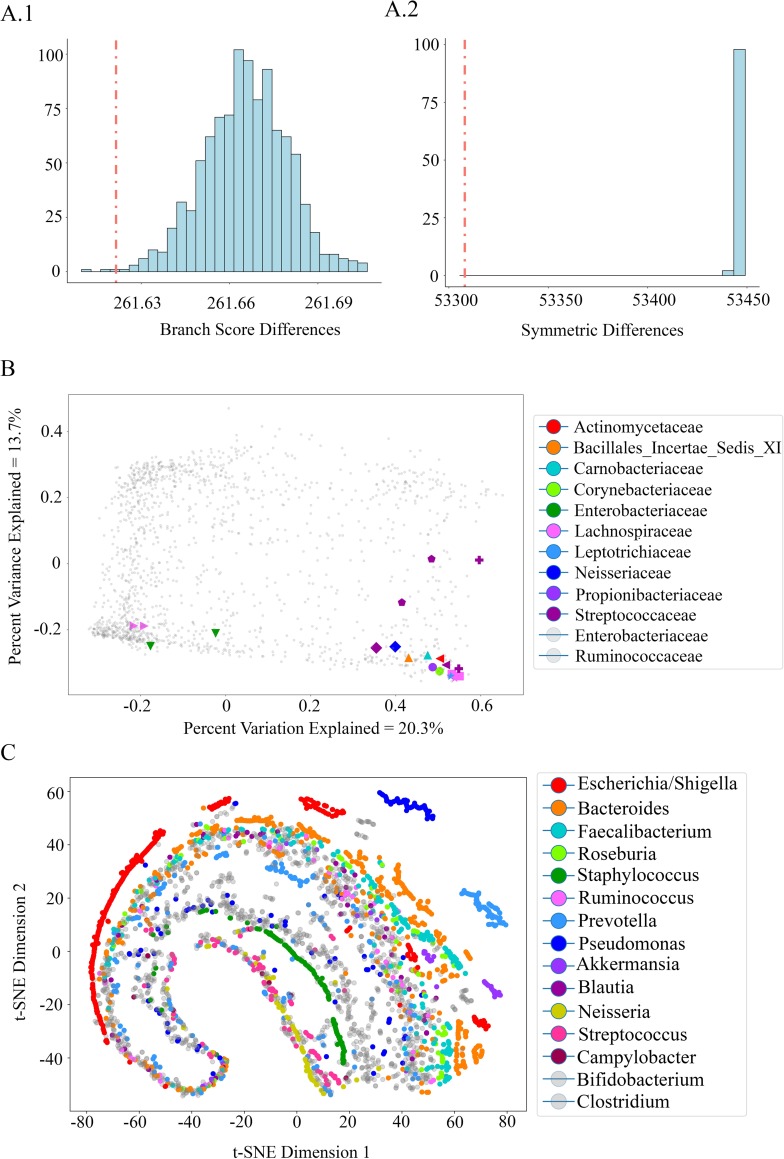
Relationship between embedding space and phylogeny.A: Hierarchical clustering of ASVs using similarity between property vectors matches phylogenetic tree topology. Histograms (light blue) show branch score distances (A1) and symmetric distances (A2) between permuted phylogenetic trees and hierarchically clustered trees based on property similarity. The dotted red line shows the distance between the true phylogenetic tree and the property-based tree. B: 2D PCoA ordination using cosine distance of 1500 randomly selected ASVs in embedding space. 10 pairs of ASVs were selected based on their high spearman correlation in the American Gut ASV table across all samples(r > 0.7). Each pair is denoted by shape. Color shows the family classification of the selected pairs, and all other ASVs are shown in grey. C: t-SNE ordination using cosine distance of 5000 randomly selected ASVs, colored by genus. 3 genera highlighted in the dashed circle exhibit similar co-occurrence patterns.